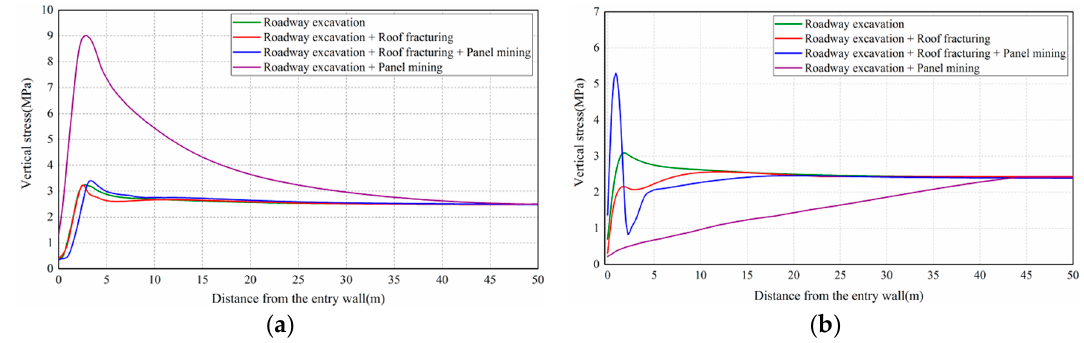
Figure 10. Stress distributions on the entry sides: ( a ) Monitoring results for the non-fracturing side; ( b ) Monitoring results for the fracturing side.